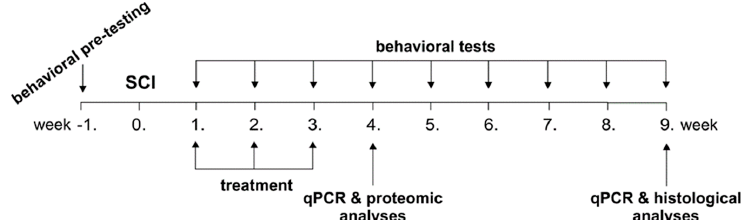
Figure 1. Time schedule of experiments. Following a spinal cord injury (SCI), the rats were treated by saline (ctrl), non-conditioned (control) medium (cM), conditioned medium (CM) and Wharton’s jelly derived mesenchymal stromal cells (WJ-MSCs) in the 1 st , 2 nd and 3 rd week. The rats were behaviorally tested weekly up to the 9 th week and analysed using qPCR (4 th and 9 th week), proteomic (4 th week) and histological (9 th week) analyses.